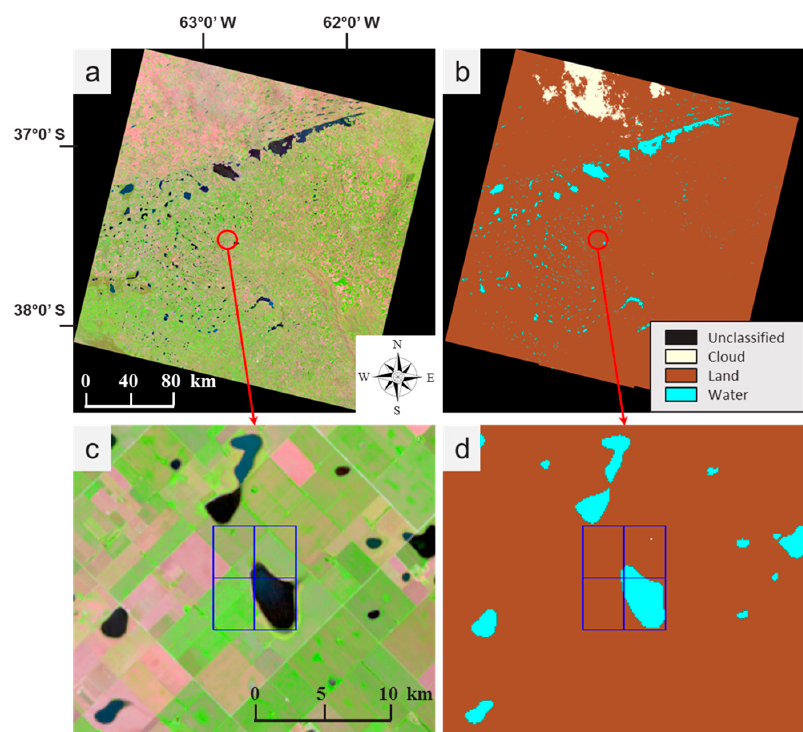
Figure C3. ( a ) The Landsat 8 scene LC82270862014319LGN00, downloaded for location: 37°S, 63°W (Argentina), was acquired on 15 November 2014. ( b ) Decision Tree Classifier (DTC) result for the same Landsat 8 scene. ( c , d ) Details showing in blue the four PROBA-V pixels overlaid, which are also indicated in Figure C4.